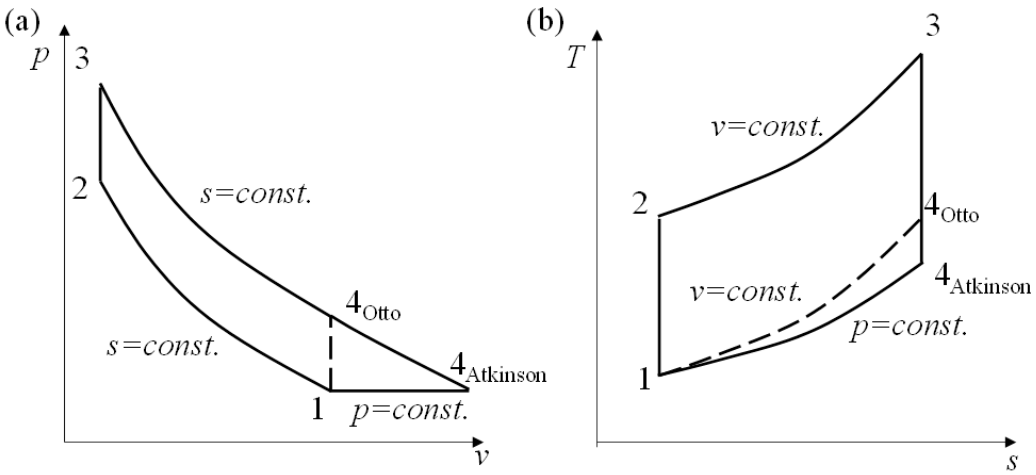
Figure 1. p-v and T-s diagram of Otto cycle and Atkinson cycle.